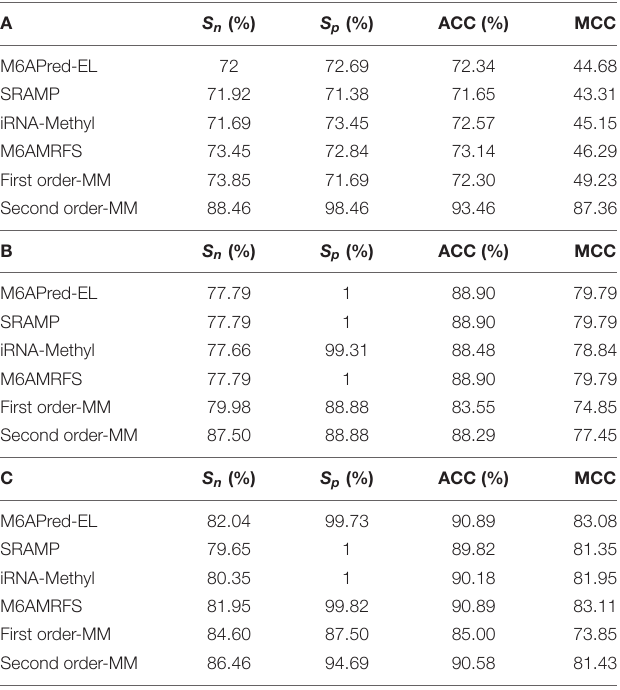
TABLE 2 | Evaluation data comparison table of six methods in (A) S. cerevisiae , (B) mouse, and (C) H. sapiens .